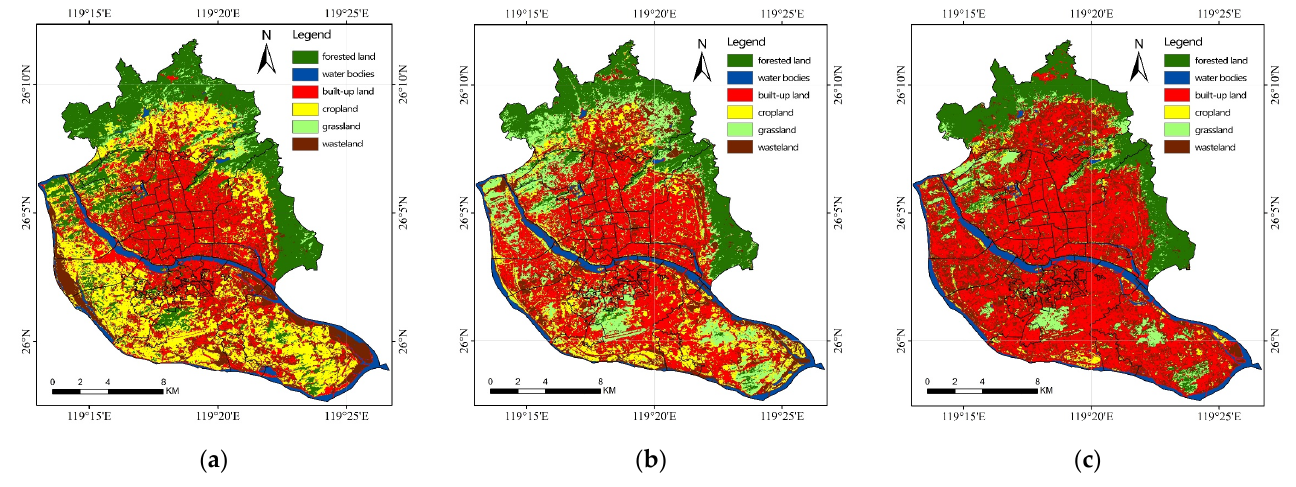
Figure 5. land use of Fuzhou: ( a ) land use of 2000; ( b ) land use of 2010; ( c ) land use of 2021.